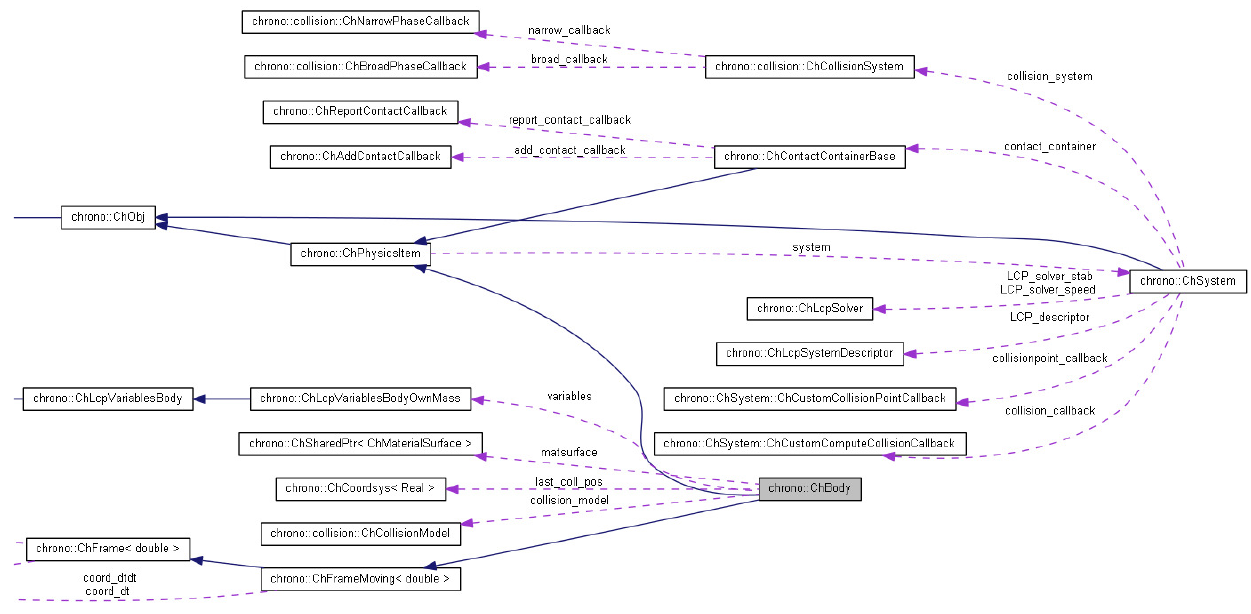
Figure 3. Collaboration graph between classes: example for ChBody and ChSystem Figure 3 : Collaboration graph between classes: example for ChBody and ChSystem .